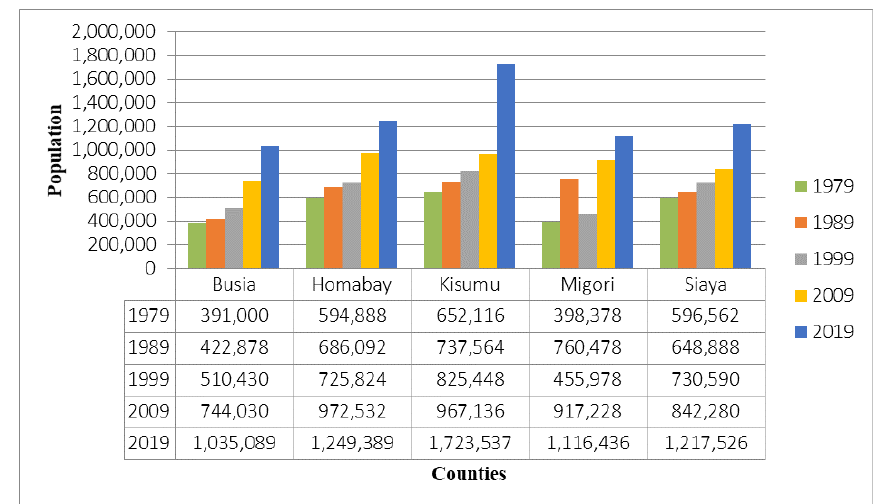
Fig. 5. County-wise population growth in the Kenyan Lake Victoria Basin, 1979 - 2019